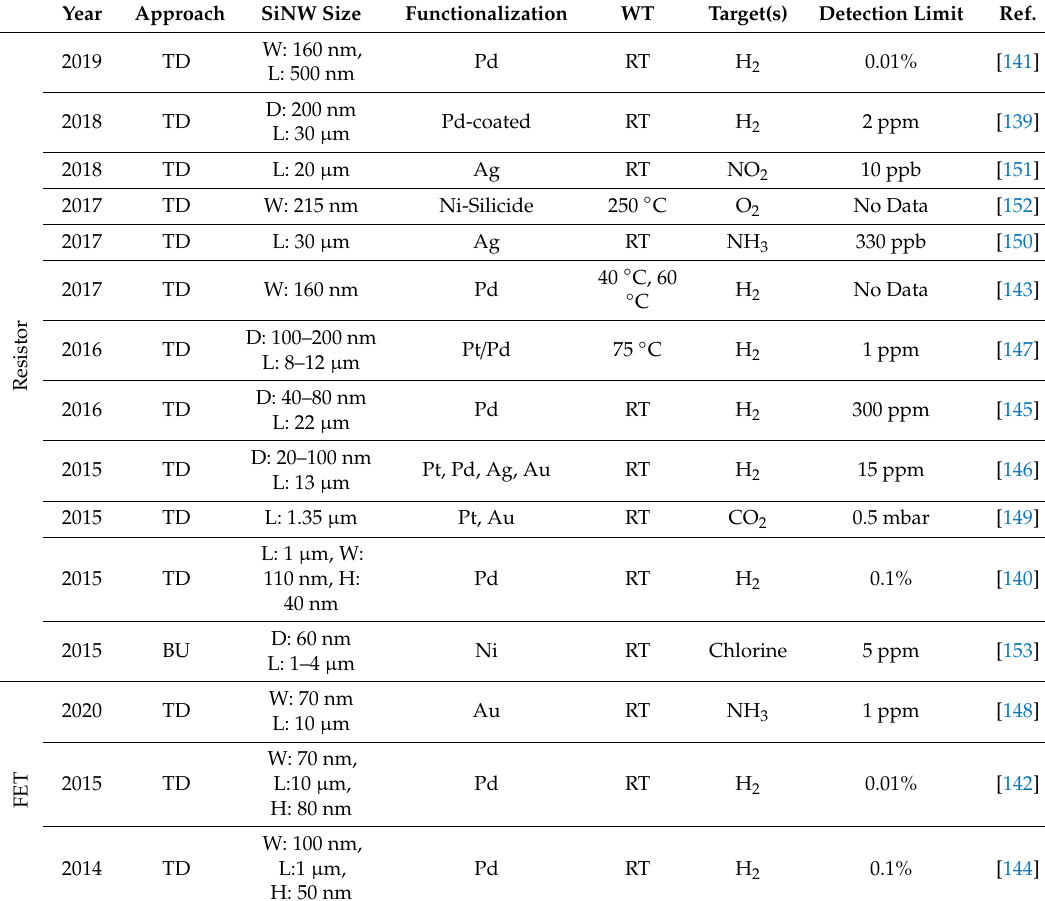
Overview of recent research works related to SiNW gas sensors functionalized by metal nanoparticles. SiNW Size Functionalization WT Target(s) Detection Limit